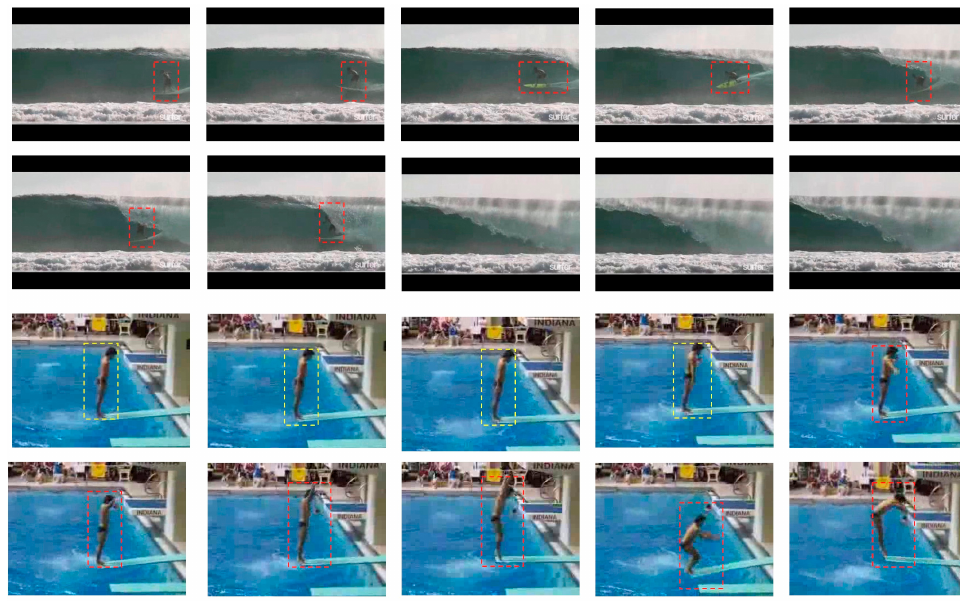
Figure 2. Two video examples from UCF-101 datasets.